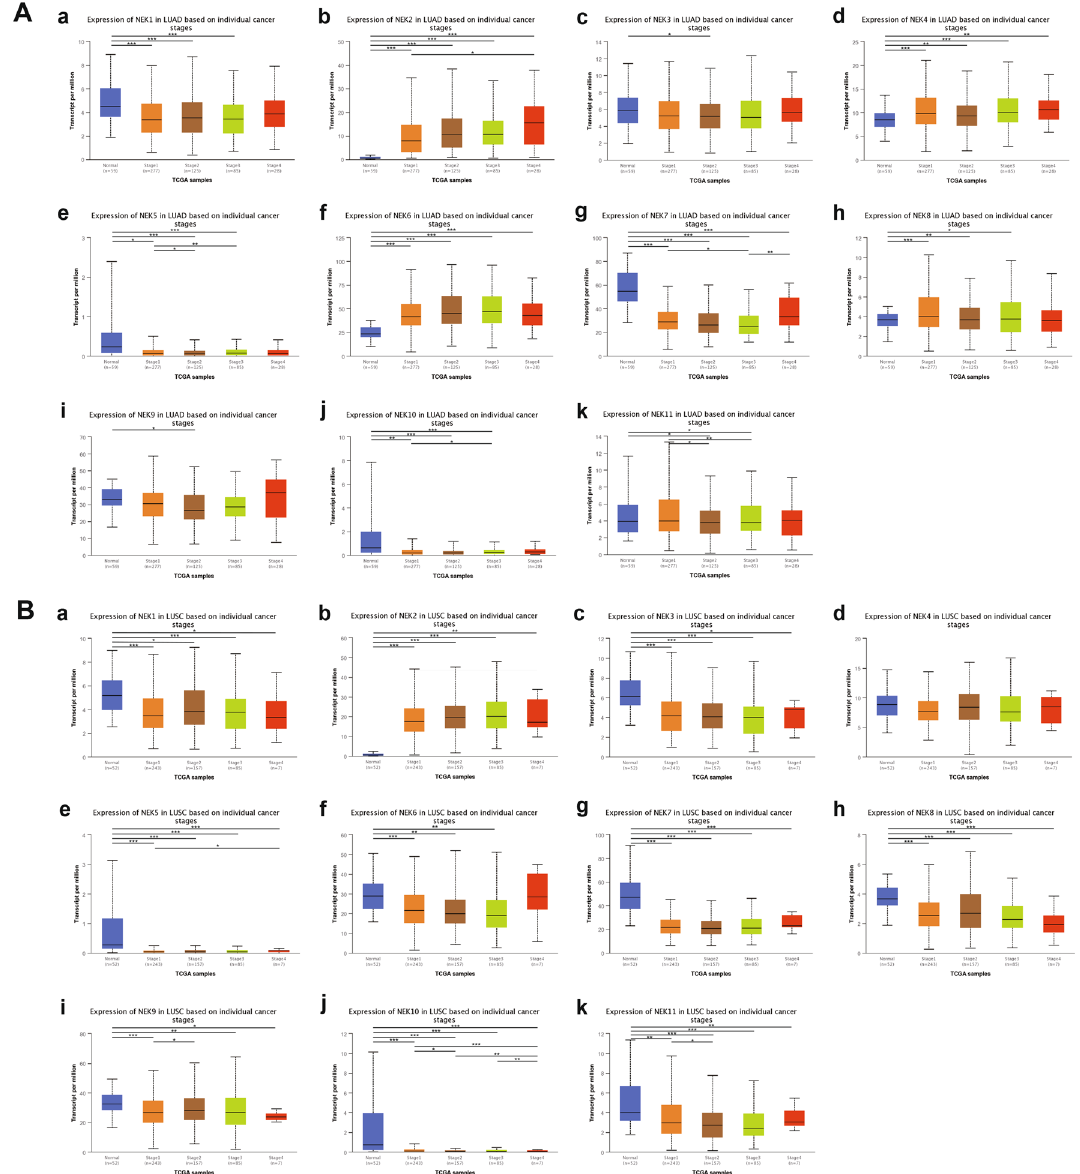
Figure 4. Relationship between mRNA expression of distinct NEKs family members and individual cancer stages of NSCLC patients. A From a to k represent the relationship between mRNA expression of NEK1 to NEK11 and individual cancer stages of LUAD patients; B From a to k represent the relationship between mRNA expression of NEK1 to NEK11 and individual cancer stages of LUSC